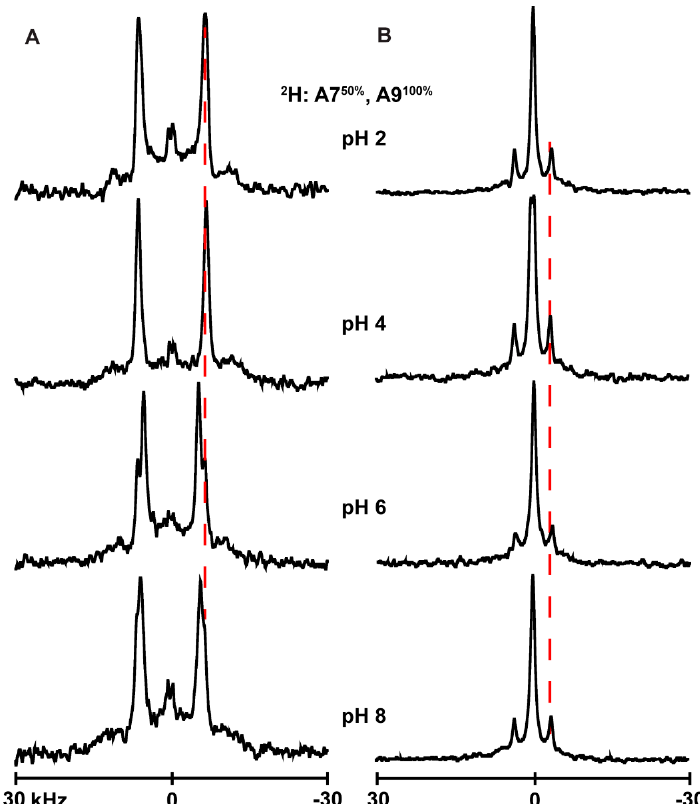
Figure 7. Selected 2 H NMR spectra to show the pH dependence of resonances for labeled A7 and A9 of H 2 GWALP23 in DLPC (A) and DOPC (B) lipid bilayers. Temperature 50 °C; β =90° sample orientation.